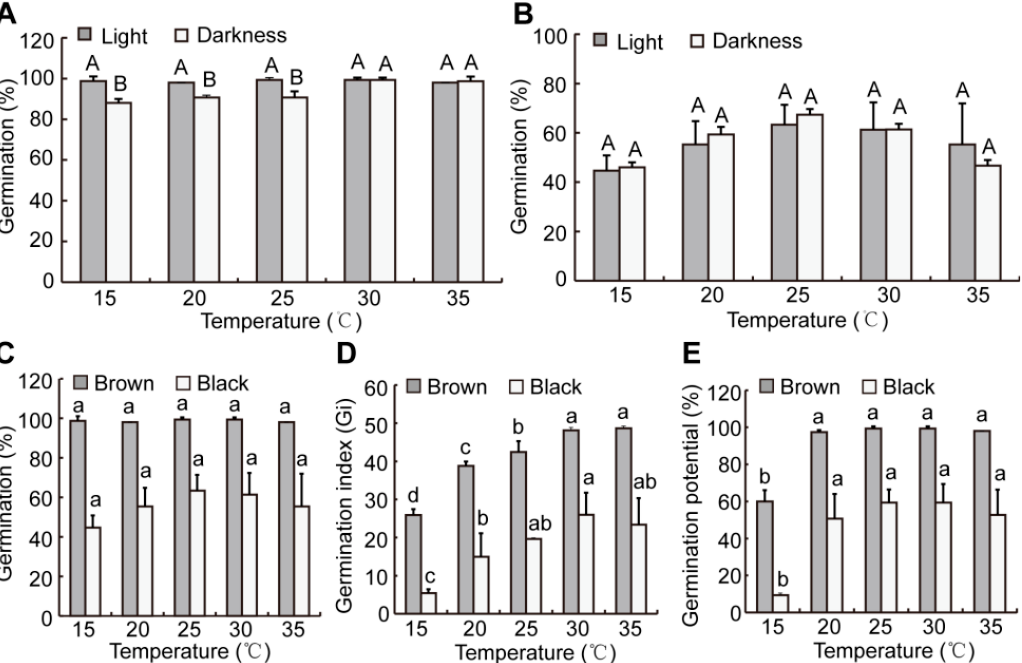
Figure 5. Effects of light and temperature on germination of brown ( A ) and black ( B ) seeds in S. liaotungensis . Effect of temperature on germination ( C ), germination index ( D ), and germination potential ( E ) of dimorphic seeds of S. liaotungensis in light conditions. There were 50 seeds counted for each replicate. Different upper-case letters show significant differences in germination percentage for the same seed type and temperature between light and darkness conditions ( t -test, p < 0.05). Different lower-case letters show significant differences in germination percentage, germi- nation index, or germination potential at different temperatures for the same seed type (LSD test, p < 0.05).